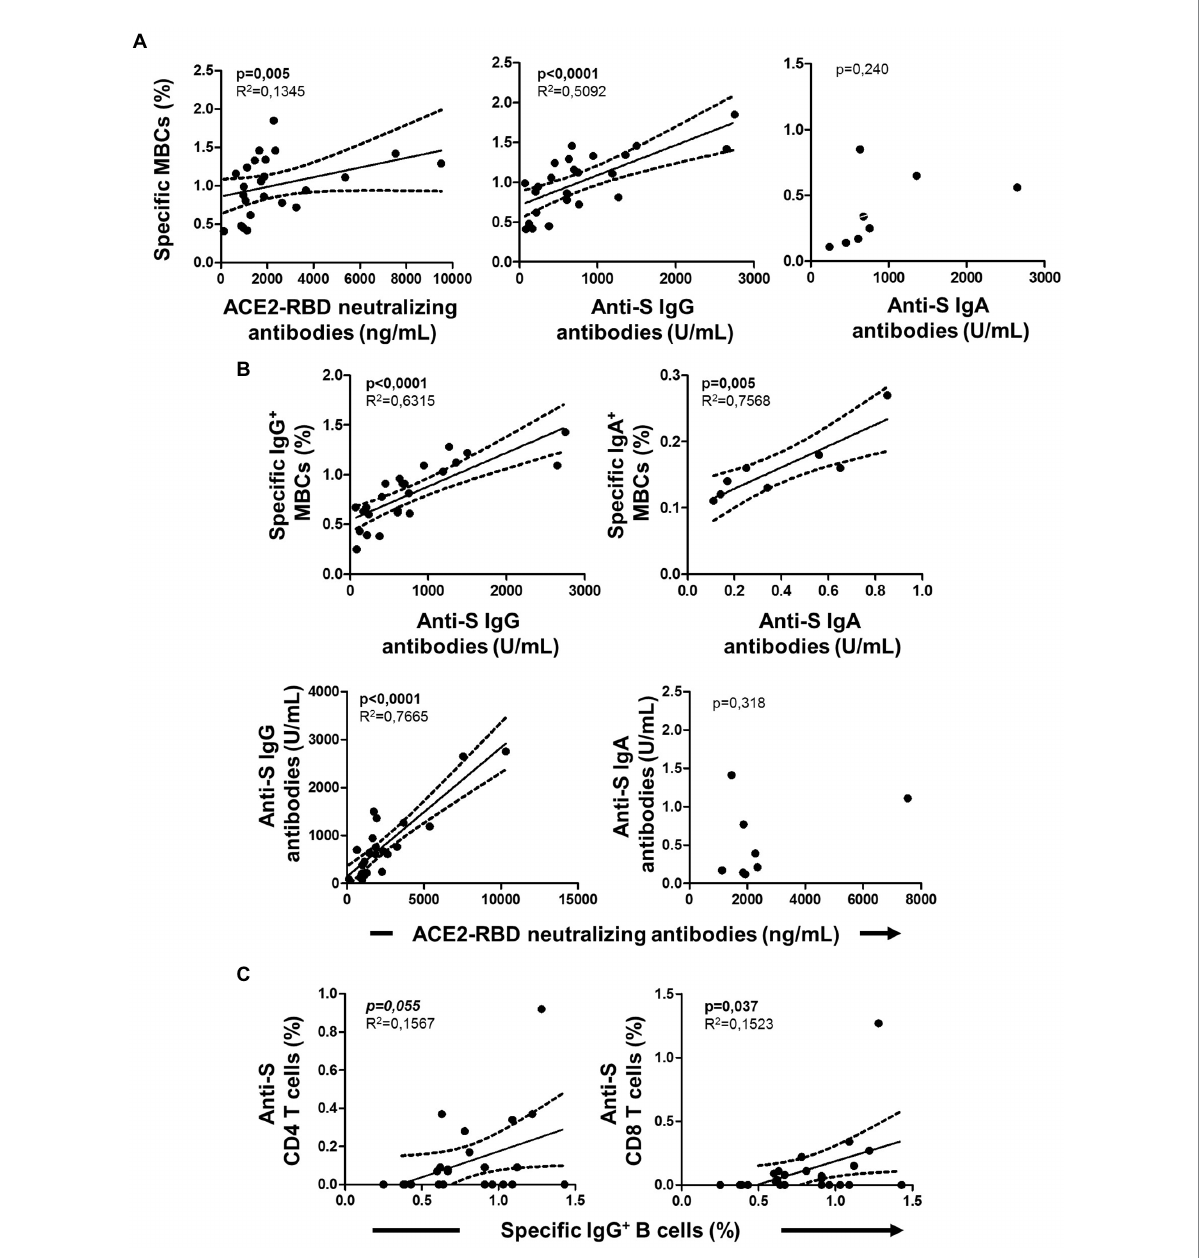
FIGURE 4 Associations of cellular immunity with specific serology at baseline in IgG + MBC + group. (A) Association of specific memory B cells (MBCs) with ACE2-RBD neutralizing antibodies, anti-S IgG and anti-S IgA antibodies. (B) Association of specific isotype IgG and IgA MBCs with anti-S IgG and anti-S IgA antibodies, respectively. Association of ACE2-RBD neutralizing antibodies with anti-S IgG and anti-S IgA antibodies. (C) Association of IgG + MBCs with anti-S CD4 and CD8 T cells. Pearson’s correlation r value and two-tailed p values are shown only when statistically significant ( p <